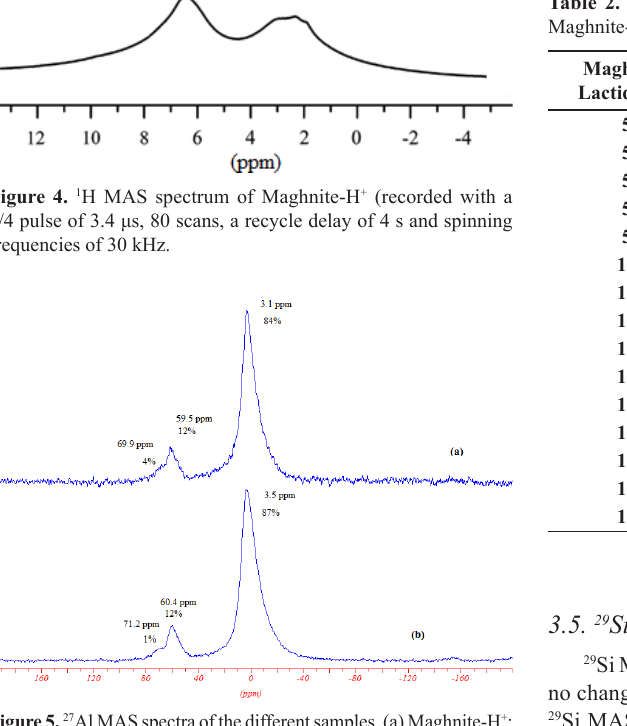
Figure 5. 27 Al MAS spectra of the different samples, (a) Maghnite-H + ; (b) Maghnite-H + /Polymer mixture after the reaction, spinning frequency: 30